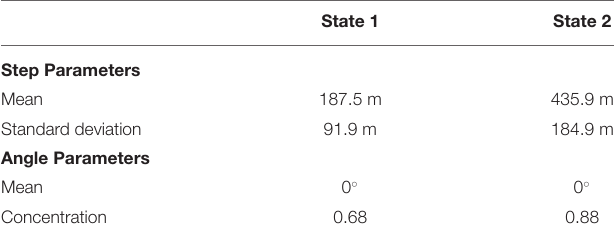
TABLE 3 | Model parameters for the best 2-state model with 5 min steps according to